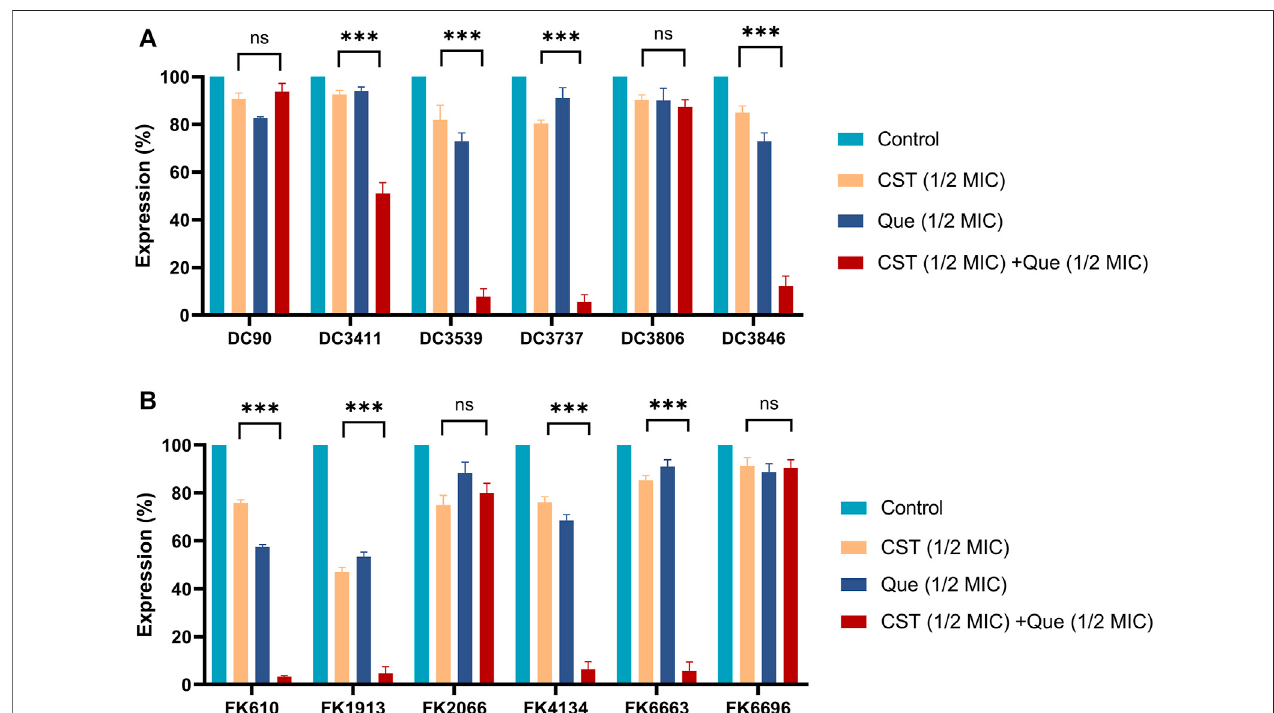
FIGURE2| Combinationofcolistinwithquercetinsigni fi cantlydownregulatesthemRNAlevelsof mcr-1 and mgrB genesin E.coli and K.pneumoniae ,respectively (A) Relative mRNA levels of mcr-1 in different E. coli strains after the various treatments (B) Relative mRNA levels of mgrB in different K. pneumoniae strains after the various treatments. 16srRNA and rpoB were used as the internal reference for E. coli and K. pneumoniae , respectively, and the mRNA levels of those two genes were taken as 100%. All experiments were performed in triplicate. The results were displayed as means ± standard deviations over the three independent experiments. ns stands for not signi fi cant, * p < 0.05, ** p < 0.01, *** p < 0.001, determined by the Student ’ s t